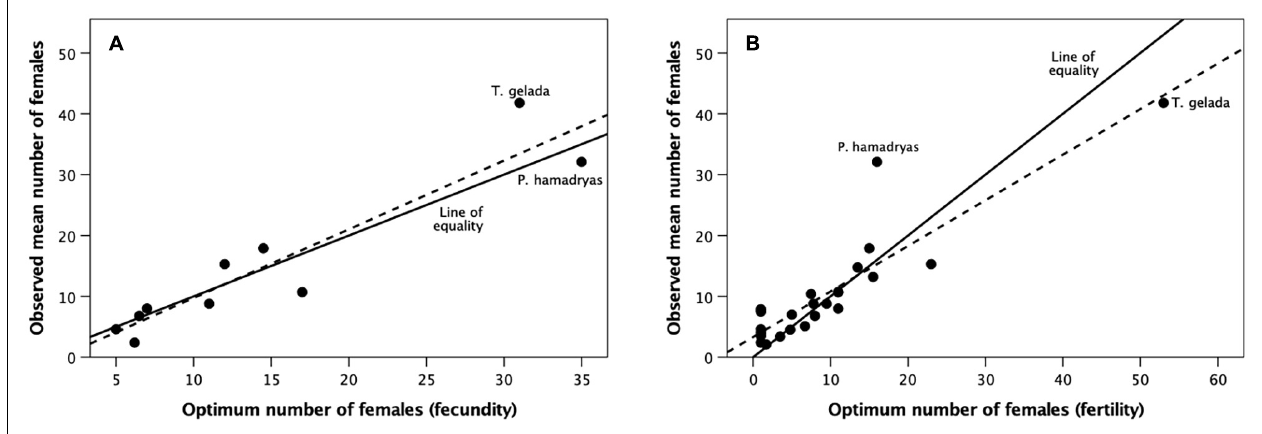
FIGURE 6 | Mean observed number of adult females per group for individual primate genera plotted against the optimum number of females that maximises (A) birth rate (from Figure 4 ) and (B) reproductive output (from Figure 5 ) for individual genera. The solid line is the line of equality (observed mean group size equals predicted group size that maximises reproductive rate); the dashed line is the best fit regression equation. Papio hamadryas and Theropithecus gelada combine female-female/female-male bonded coalitions with a modular fission-fusion social system. Source: Supplementary Dataset 5 .